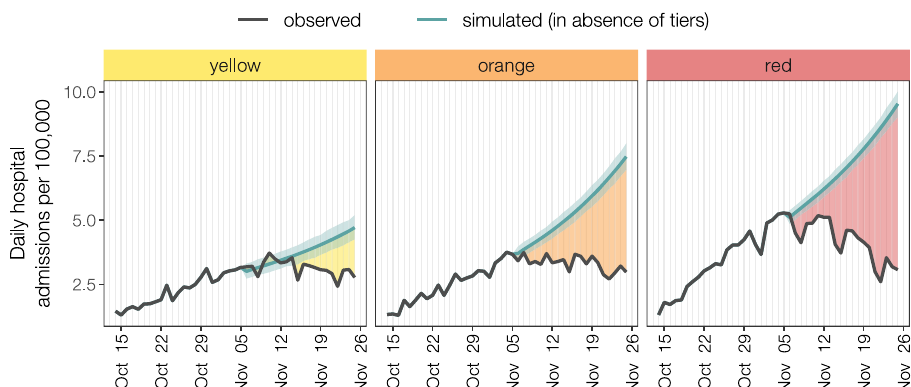
Fig. 4 Incidence of hospital admissions by tier level over the period October 14 – November 25, 2020. Regions are grouped by the maximum tier assigned over the study period. Black lines represent observed hospital admissions. Teal lines represent mean projected values (shaded area: 95% projection interval) under the assumption that national restrictions were maintained after November 6, i.e., that the reproduction number was constant over the projection period. Shaded areas between the two curves highlight averted hospitalizations, the colors of each shaded area are associated with the